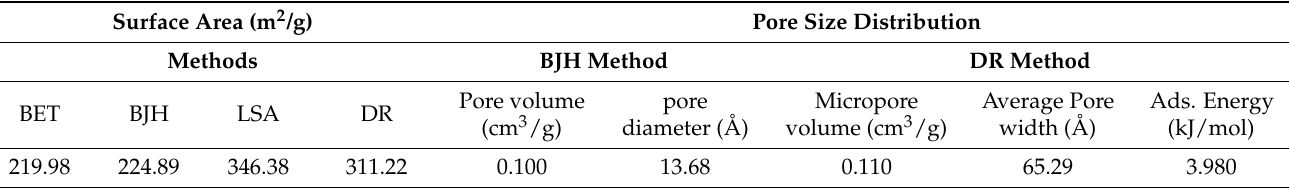
Table 2. Surface area and pore size AC derived from Paulownia tomentosa .